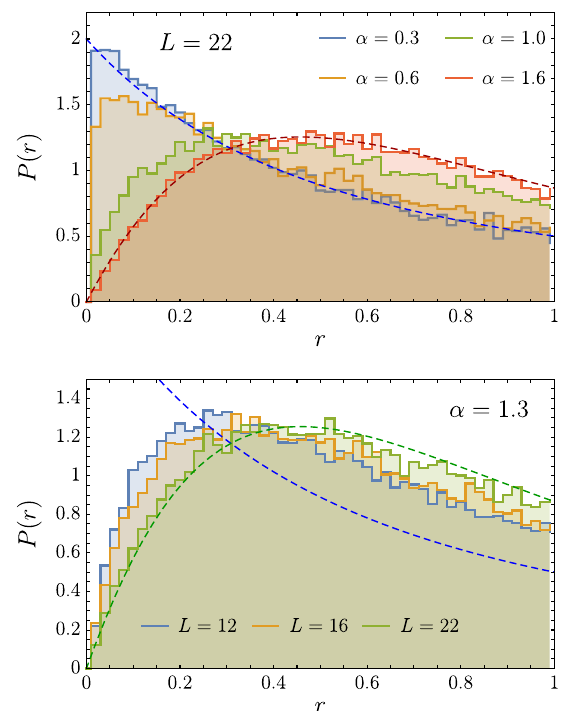
FIG. 5. Level statistics for the Heisenberg chain. Each curve in the figure is produced using at least 50 eigenstates from the middle of spectrum and 1000 realizations of disorder. The dashed lines are the Wigner-Dyson (WD) and Poisson distributions. (Top) For a fixed length L ¼ 22 and varying α . (Bottom) For a fixed α ¼ 1 . 3 and varying length L . The tendency toward the Wigner-Dyson statistics is evident at both growing L and α . However, for smaller values of α , P ð r Þ remains close to the Poisson one up to the largest available system